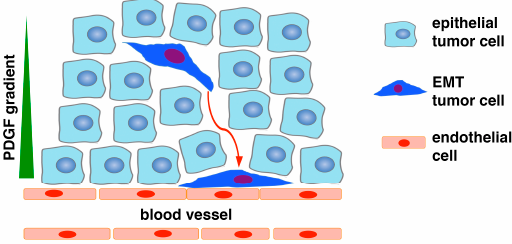
Figure 1. Schematic of epithelial-to-pericyte transition (EPT). In response to microenvironmental stimuli (e.g., hypoxia, transforming growth factor β TGF β ), a subset of carcinoma cells in the tumor mass undergo EMT, and consequently acquire increased motility and invasiveness as well as expression of PDGFR β , N-cadherin, and other pericyte markers. As endothelial cells express N-cadherin and secrete PDGF, the EMT cancer cells are chemoattracted to vasculature via PDGF paracrine signaling and associate with endothelial cells through N-cadherin-mediated adherens junctions. The EMT cells may also upregulate CXCR4 and be recruited to endothelium in response to stromal-derived factor 1 (SDF1). Due to lack of PDGFR β and N-cadherin, epithelial cancer cells without EMT are unable to respond to PDGF or interact with endothelium. The EMT cancer cells functionally resemble pericytes to stabilize blood vessels to fuel tumor